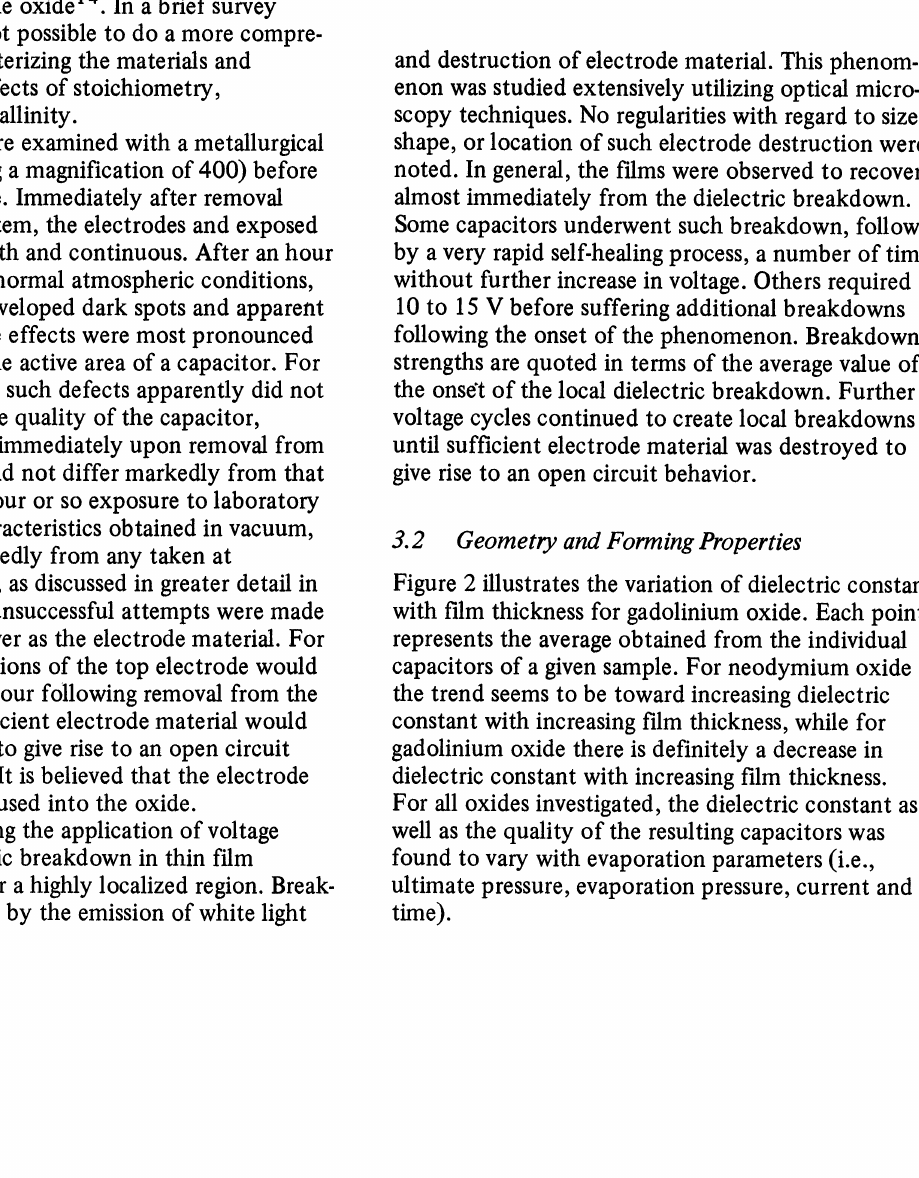
FIGURE 2 Relative dielectric constant versus film thickness for gadolinium